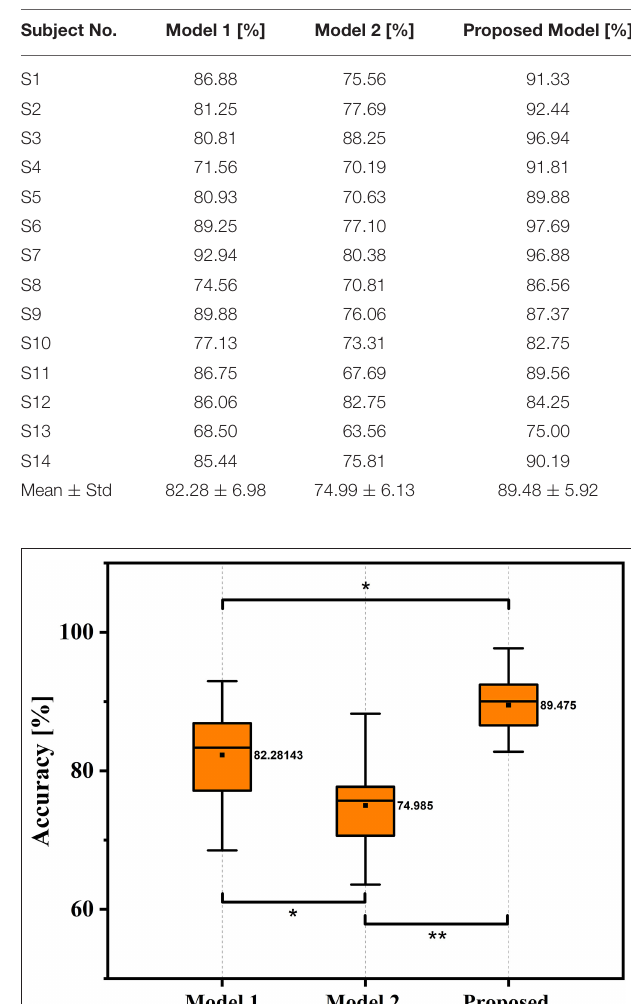
TABLE 3 | Decoding accuracies across subjects under condition of W-OHM using different kinds of models.